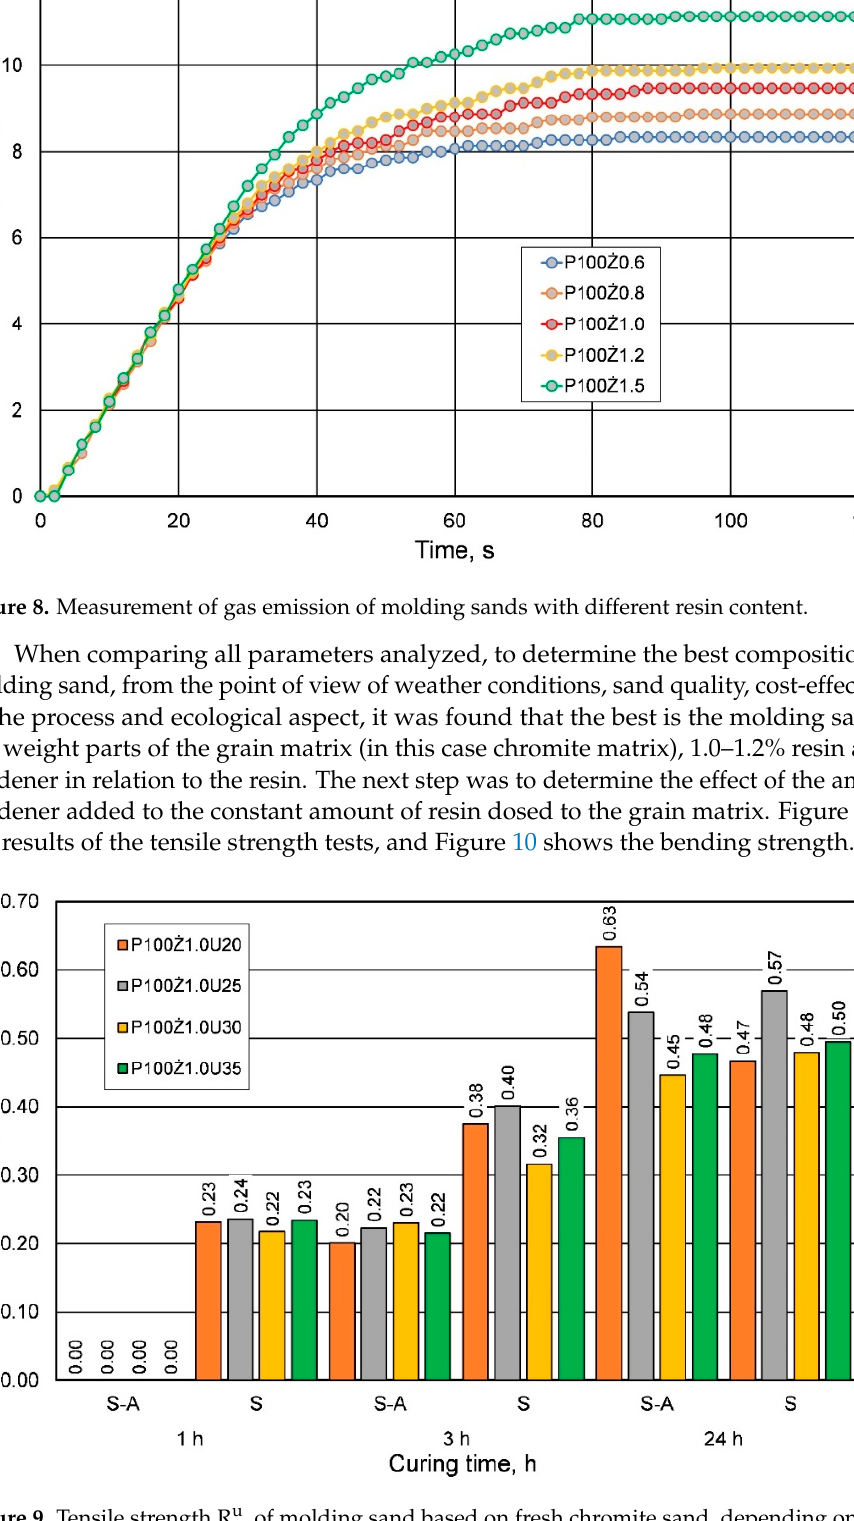
Figure 7. Measurement of Permabind resin gas emission.